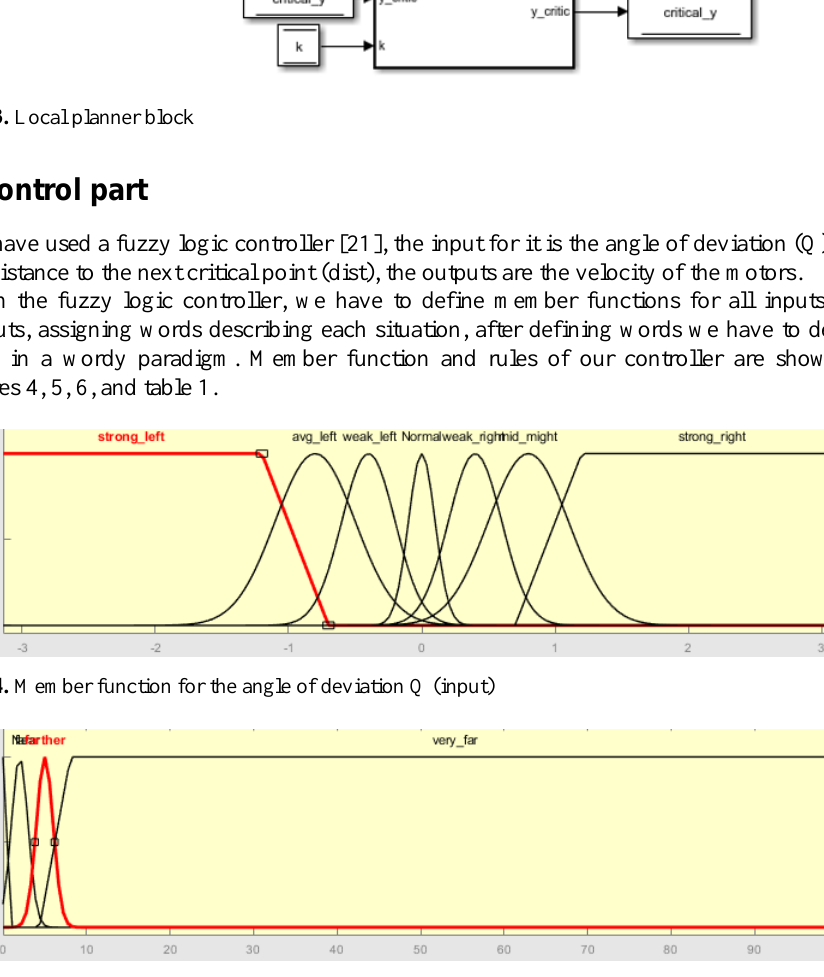
Fig. 5. Member functions for the distance to the goal (input)